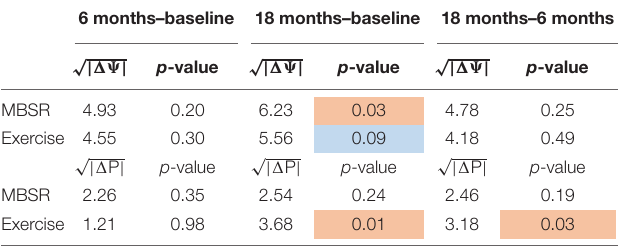
TABLE 4 | Significance testing of longitudinal effects of MBSR and exercise on covariance and correlation FC